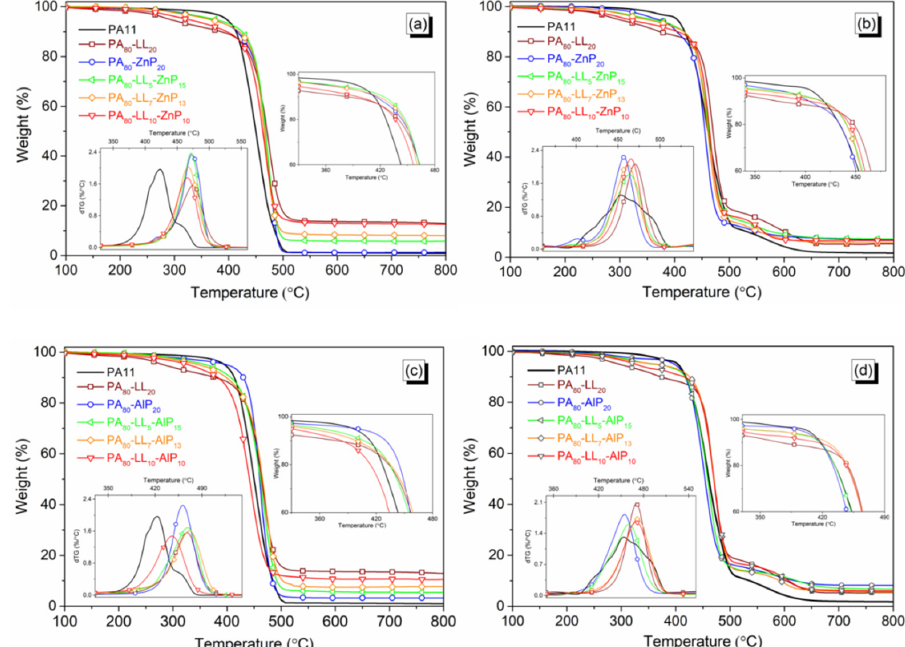
Figure 3. Thermogravimetric (TG) curves of polyamide 11 (PA11) blends of lignosulphonate lignin (LL) in combination with zinc phosphinate (ZnP) and aluminum phosphinate (AlP) in N 2 (( a ) and ( c )) and air atmosphere (( b ) and ( d )).